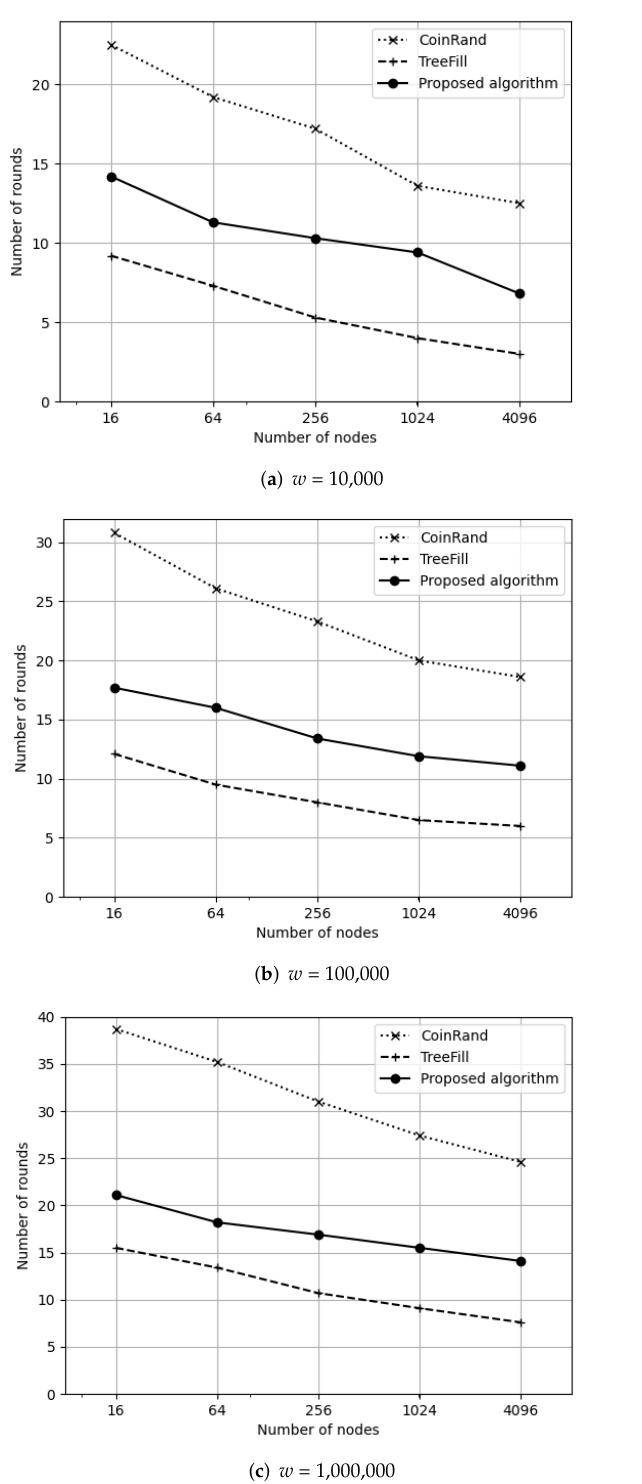
Figure 4. Comparison of the number of rounds between CoinRand , TreeFill , and the proposed algo- rithm when the number of nodes is 16, 64, 256, 1024, and